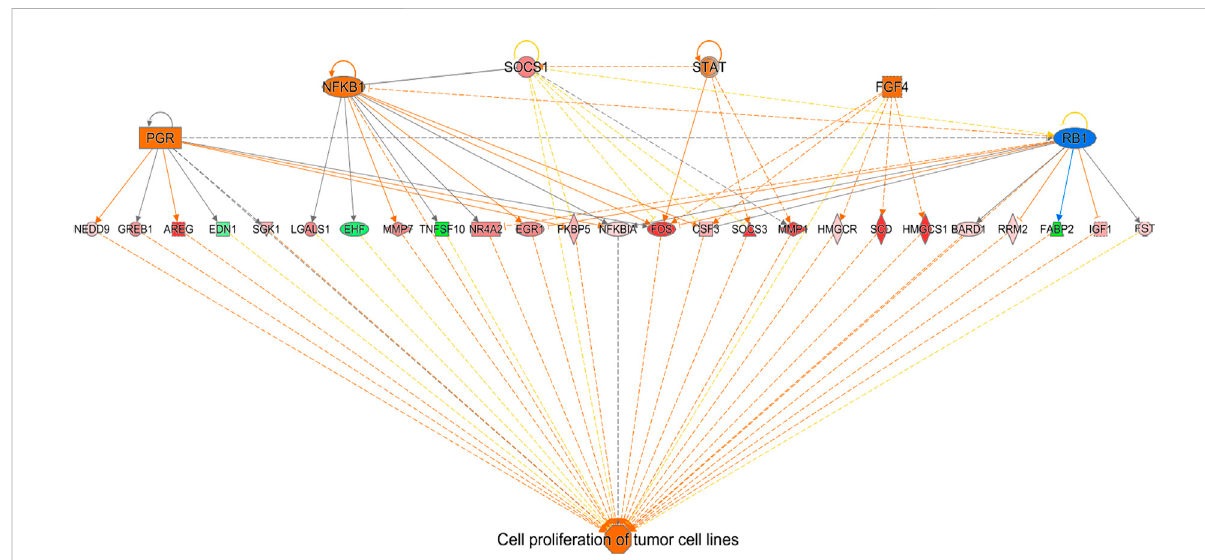
FIGURE 5 Network mapping of differentially expressed genes associated with cell proliferation between FED chicks and E18 embryos. Network mapping of differentially expressed genes (fold-change ≥ 5; FDR p -value ≤ 0.05) associated with cell proliferation between FED and E18. Genes associated with increased cell proliferation were also highly altered between FED and E18. Red molecules were signi fi cantly upregulated and green molecules signi fi cantly downregulated in FED chicks. Orange indicates predicted activation and blue indicates predicted inhibition.